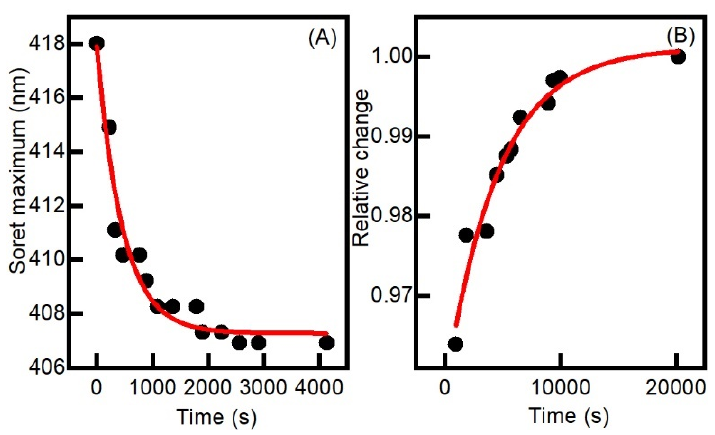
Figure 4. Decay of BsDyP compound II ( A ) and PpDyP compound I ( B ) to the respective resting states, as monitored by UV-vis absorption spectroscopy immediately after opening the electrochemical cell circuit. The ordinate axis represent the position and relative intensity of the Soret band, respectively. Table 1. Resonance Raman and UV-vis absorption marker bands for the resting state, compound I and compound II of the BsDyP and PpDyP enzymes. RR band positions are expressed in cm − 1 and UV-vis in nm. Δν ox refers to the difference in positions between compound I minus compound II.